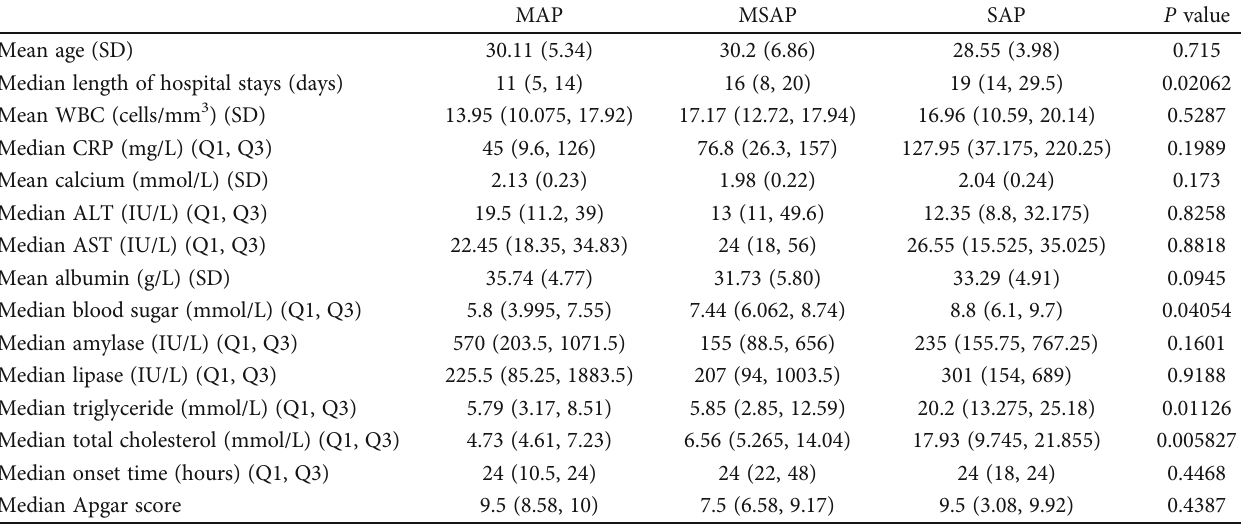
Table 2: Variation in clinical parameters and length of hospital stay between the mild and severe